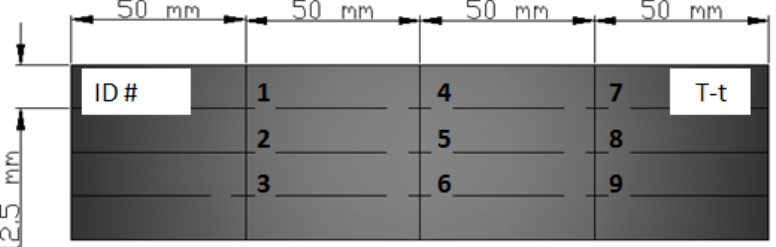
Figure 4. Measuring points of IR-heated laminates.